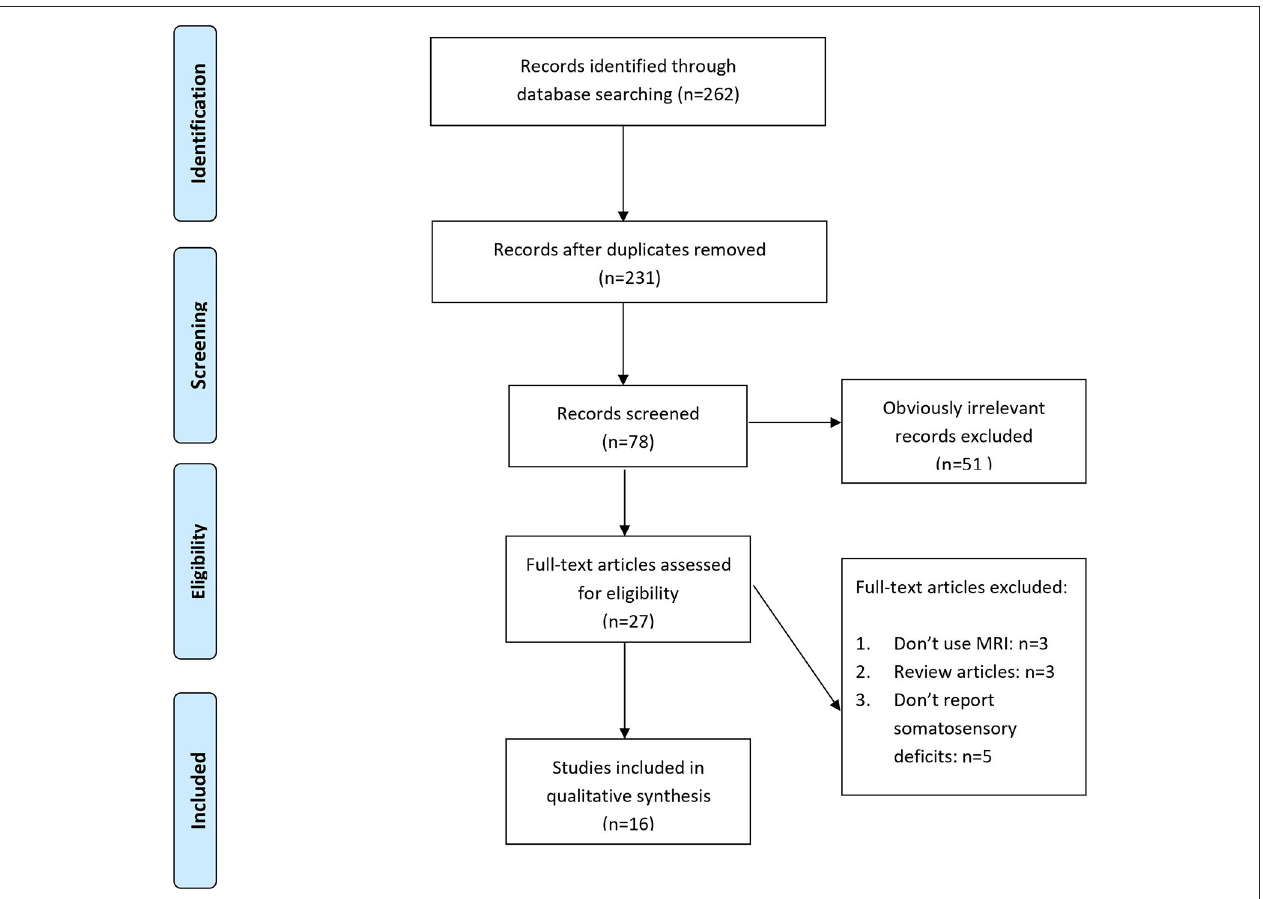
FIGURE 1 | Flow chart for study